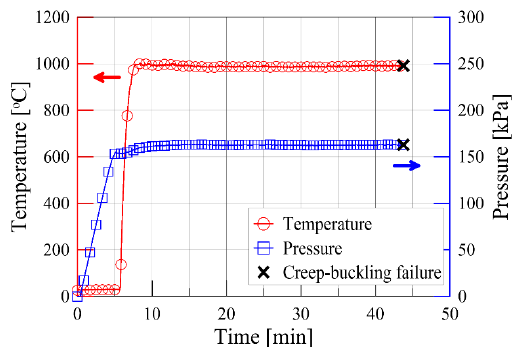
Figure 4. Typical temperature and pressure behaviors during the creep-buckling experiment.